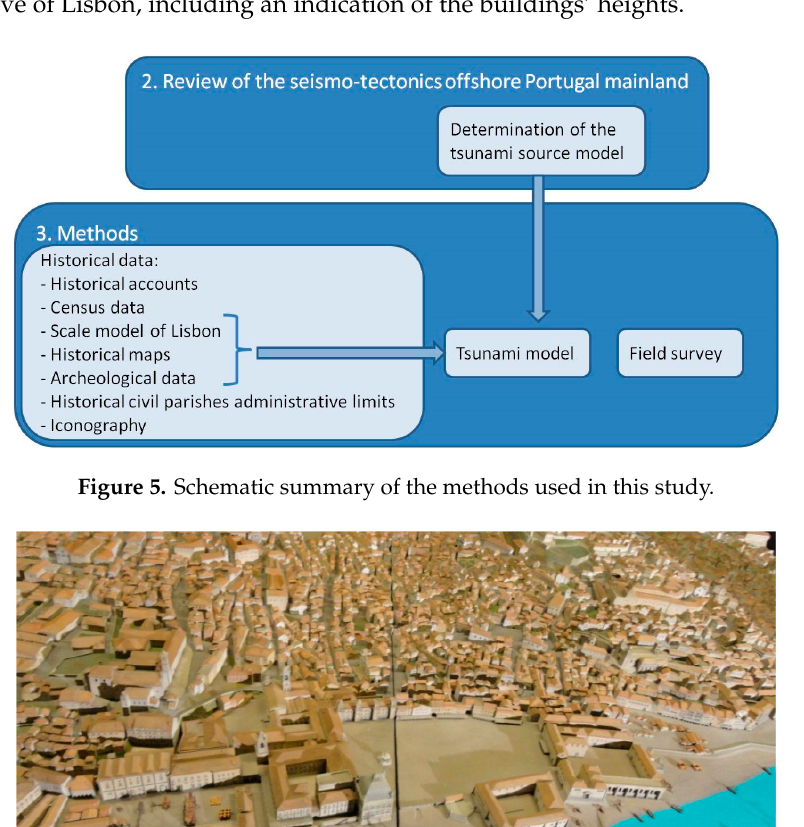
Figure 5. Schematic summary of the methods used in this study.